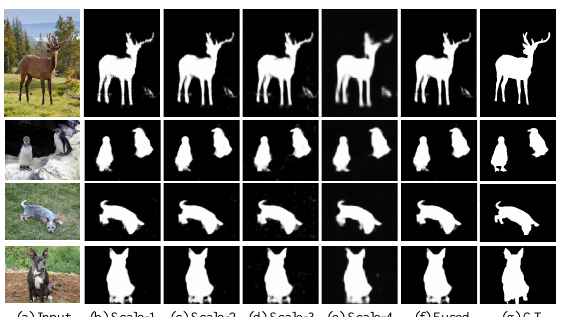
Figure 1. Saliency maps generated by the proposed multi-scale global contrast convolutional neural network (CNN). Our method predicts saliency maps in multiple scales and fuses them to obtain the final